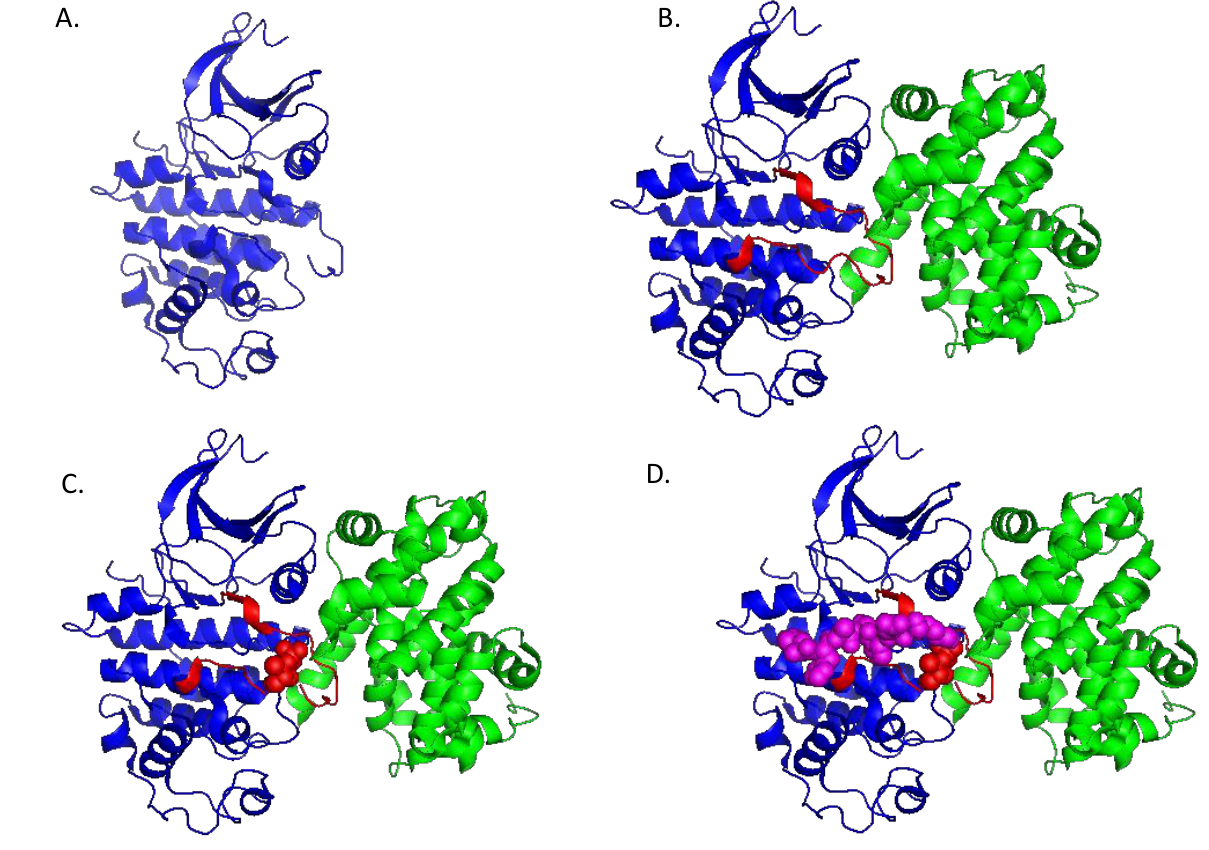
Figure 3. Structures of monomeric CDK2 and CDK2/CyclinA. ( A ) Structural representation of CDK2; ( B ) Structural representation of CDK2/Cyclin A complex (PDB: 1QMZ); ( C ) Structural representation of phospho Thr160-CDK2/Cyclin A; ( D ) Structural representation of phospho Thr160-CDK2/Cyclin A bound to a peptide